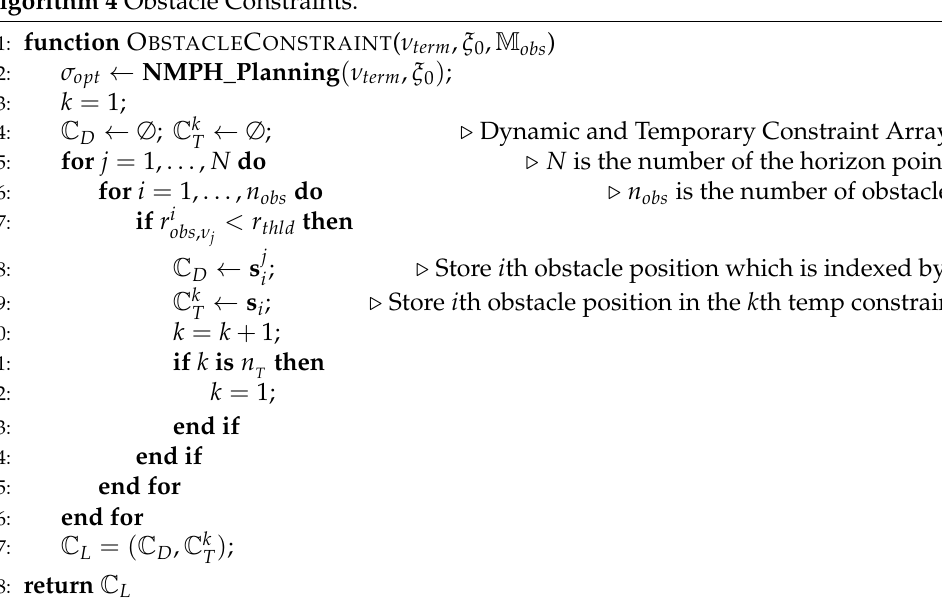
Algorithm 4 Obstacle